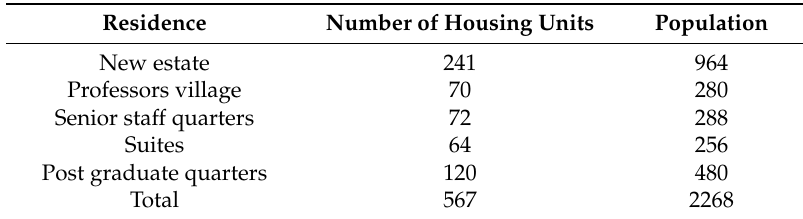
Table 2. Covenant University staff residence population.